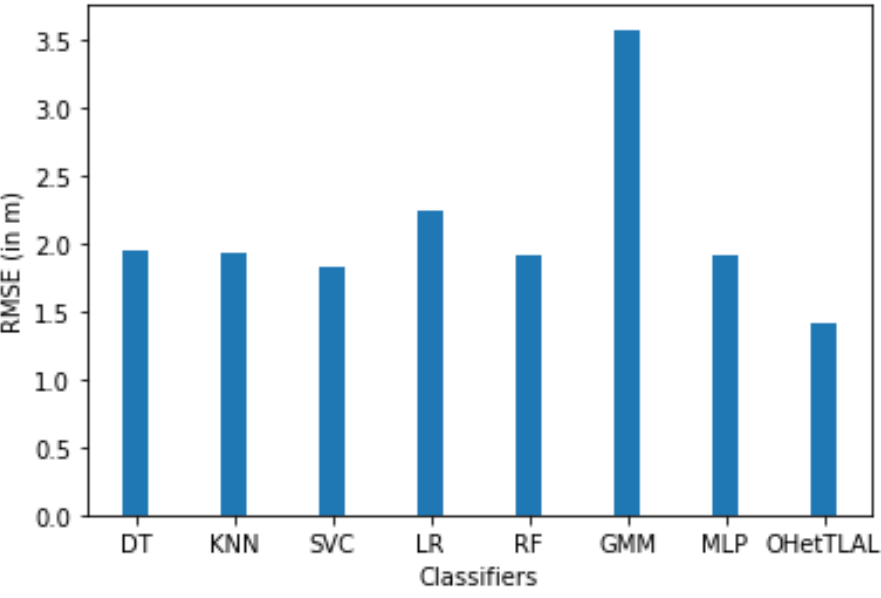
Figure 21. Comparisons of classifier’s RMSE (in meter) for dataset B with 6 Wi-Fi APs.